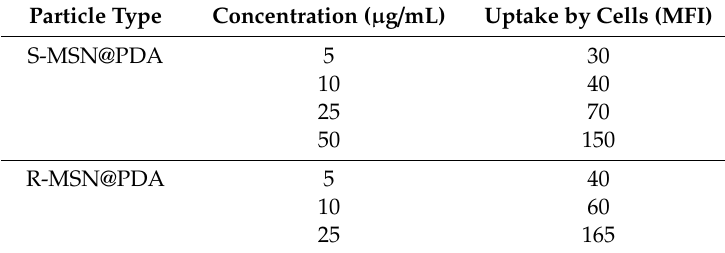
Table 2. The uptake (MFI) of the MDA-MB-231 cells by S-MSN@PDA and R-MSN@PDA at di ff erent concentrations ( µ g / mL) as calculated from